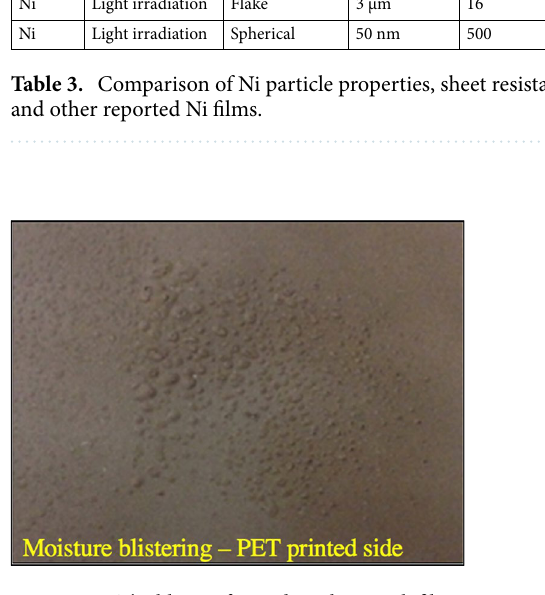
Figure 13. The blisters formed on the Ni ink